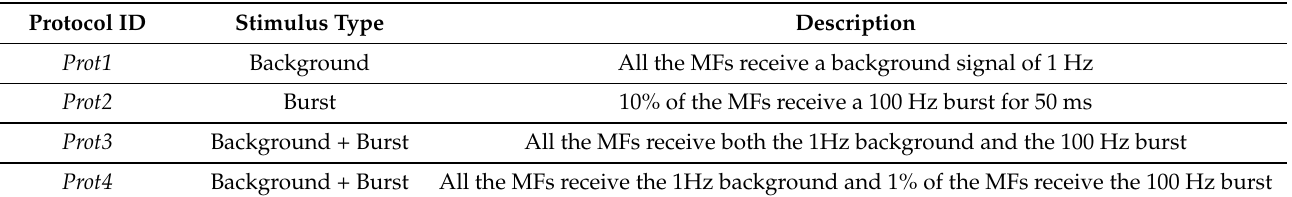
Table 4. Features of the simulated granular layer